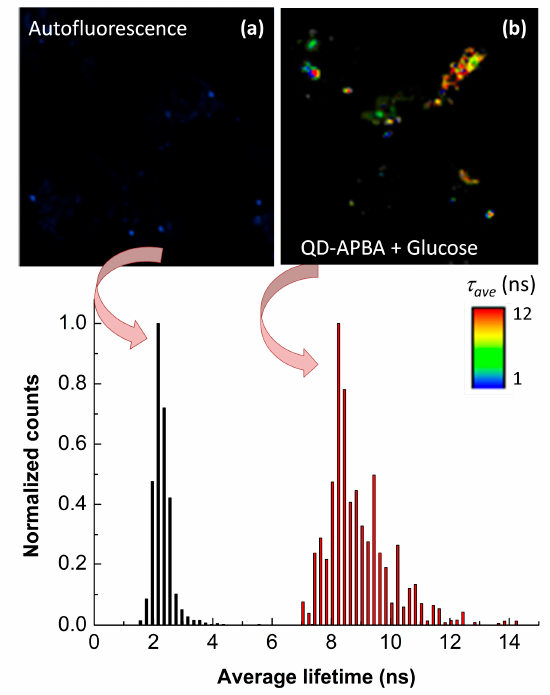
Figure 6. Fluorescence lifetime imaging microscopy (FLIM) images and the corresponding PL lifetime distributions of ( a ) MDA-MB-231 cell autofluorescence and ( b ) MDA-MB-231 cells after 3 h incubation with QD–APBA conjugates and 50 mM glucose.